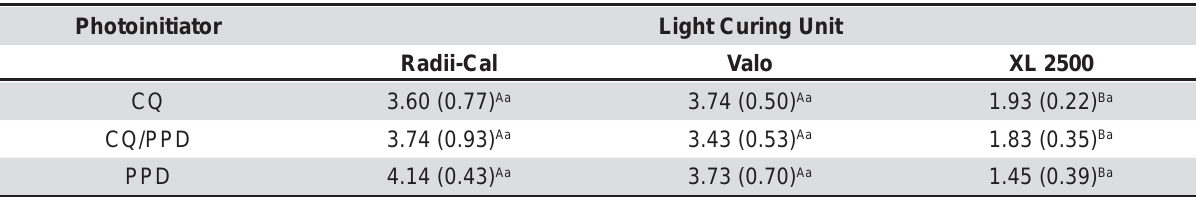
Table 3- Mean YM value (GPa) and standard error (±) provided for each of the photoinitiator systems Photoinitiator